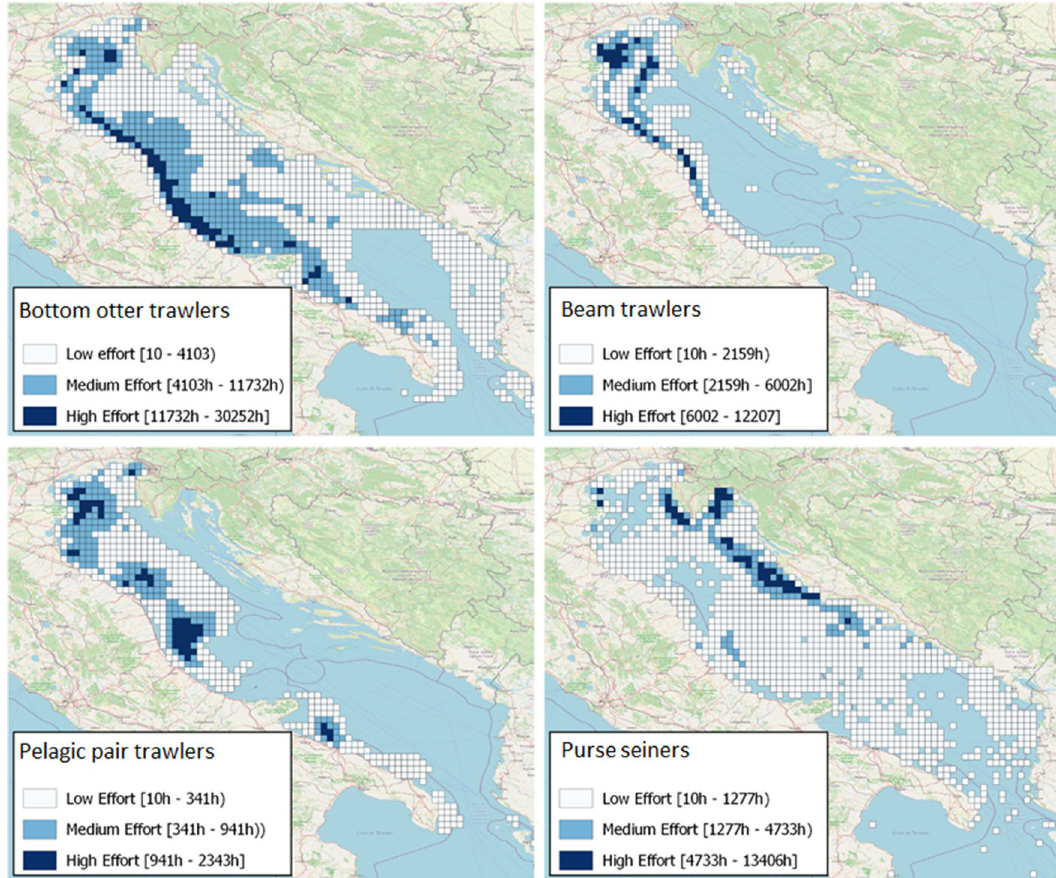
Figure 2. Spatial distributions, in the Adriatic Sea, of cumulative 2015–2020 fishing hours by estimated fishing ◦ gear at a 0.1 resolution. Maps were created with QGIS v.3.20.2 (www. qgis. org) using the OSM-Standard map of the QuickMapService plugin as the background